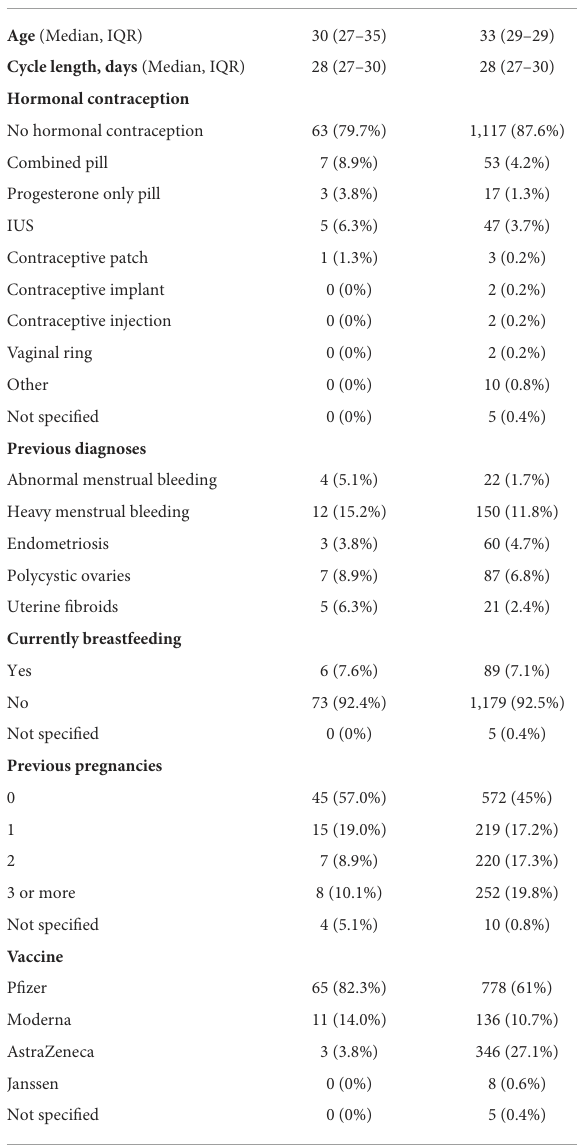
TABLE 1 Demographic characteristics of participants in the prospective and retrospective